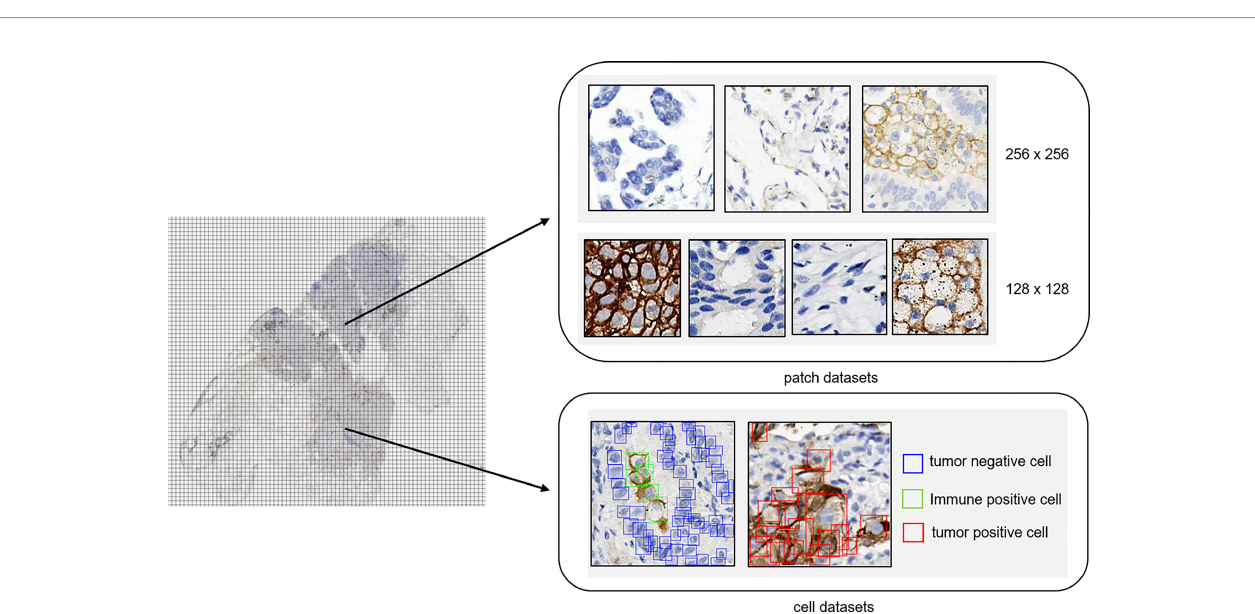
TPS, tumor proportion score; CPS, combined positive score; NA, not